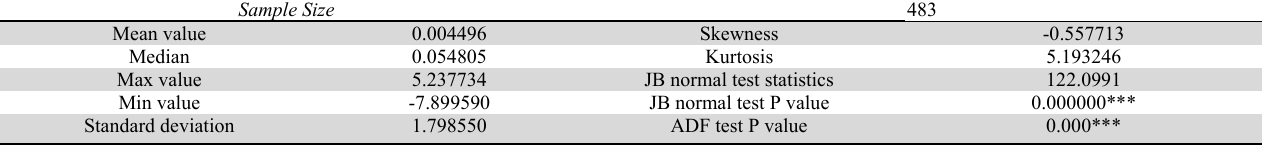
Table of basic statistical characteristics of relative volatility time sequence (PT) of hot rolled coils futures price Sample Size 483 Mean value